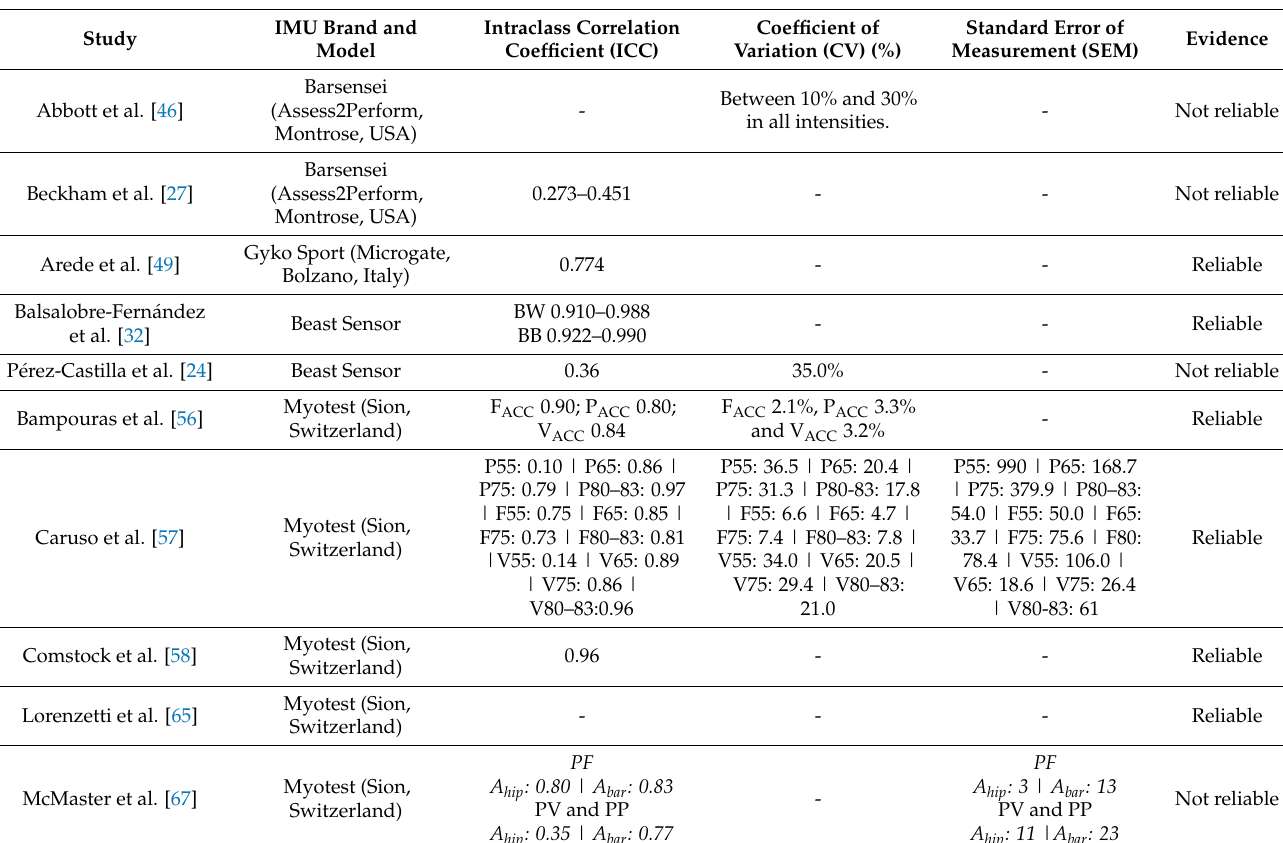
Table 5. Reliability of IMU for estimation of barbell